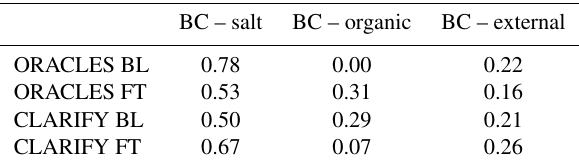
Table 2. Black carbon mixing state by campaign in the FT or BL. BC–salt and BC–organic refer to internally mixed